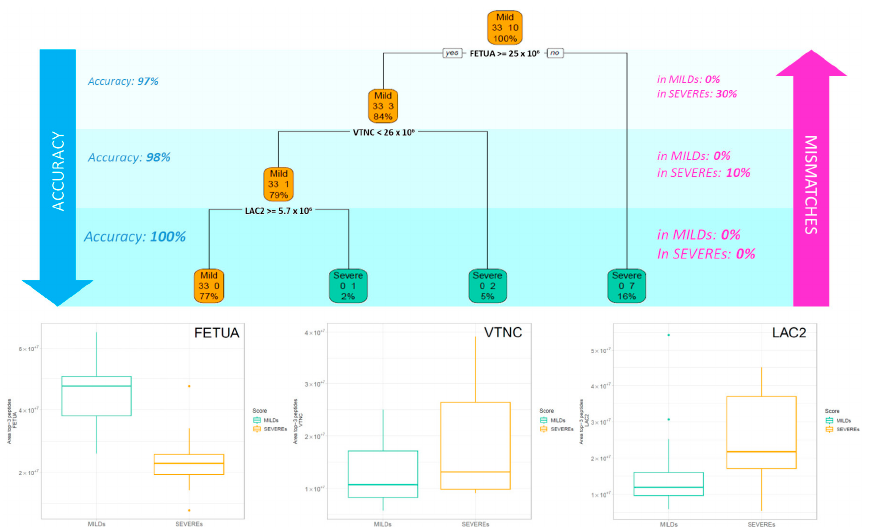
Figure 3. Decision tree of all 43 patients. The decision tree (DT) selects the most impactful proteins with the relative cut-off able to discriminate between the two classes. In each box are reported: the more frequent class indicated by the caption “Mild” or “Severe,” the number of cases belonging to the two classes and the percentage of patients in that box. The boxplot of the three selected proteins by the DT are reported for Mild and Severe patients.